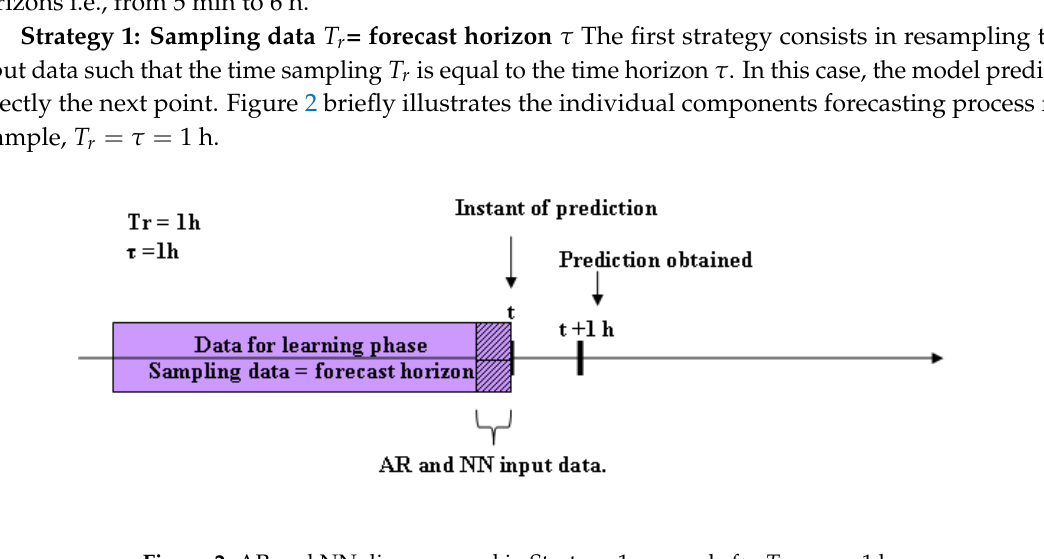
Figure 2. AR and NN diagram used in Strategy 1: example for T r = τ = 1